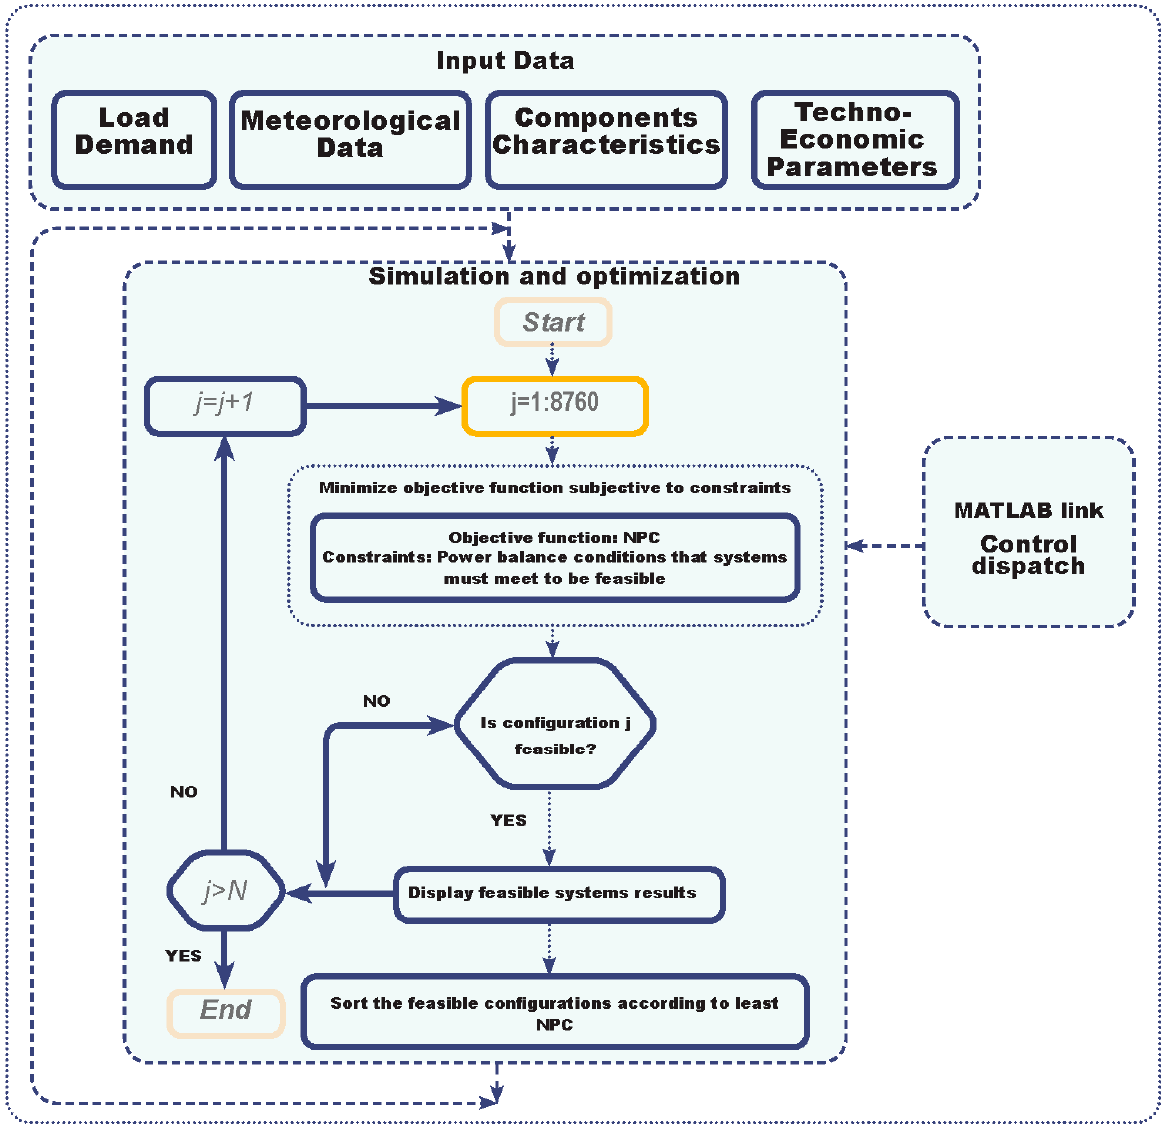
Figure 3. Flowchart of the analysis procedure.